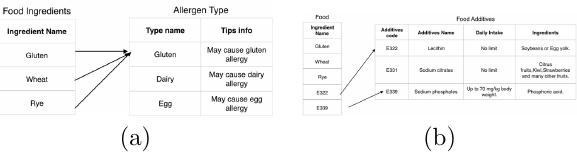
Figure 5. Relationship between food ingredients and health